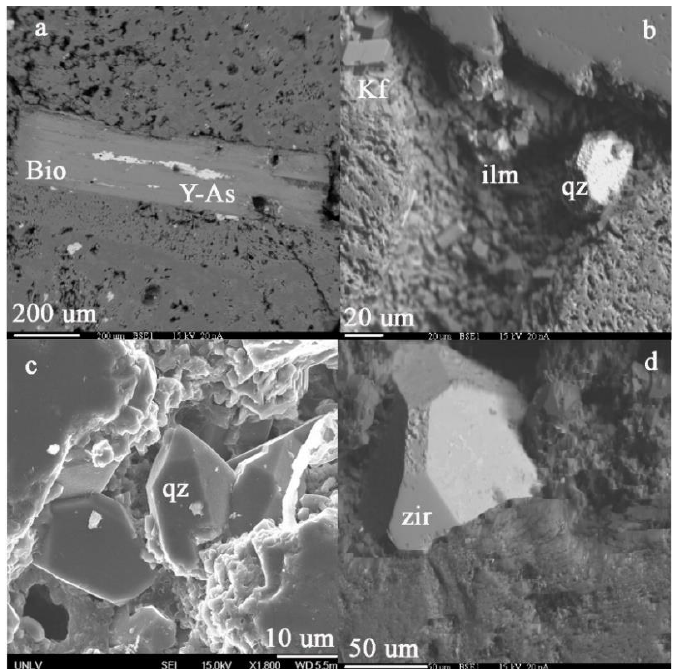
Figure 4. Different types of arsenic phases and their relations with other minerals. ( a ) As–Y phase (Y–As) included in biotite (Bio). ( b ) Euhedral sanidine (Kf), ilmenite (ilm), and quartz (qz) coexist with arsenogoyazite-like crystals in the vesicle. ( c ) Euhedral quartz and sanidine in the vesicle. ( d ) Euhedral zircon in the vesicle.